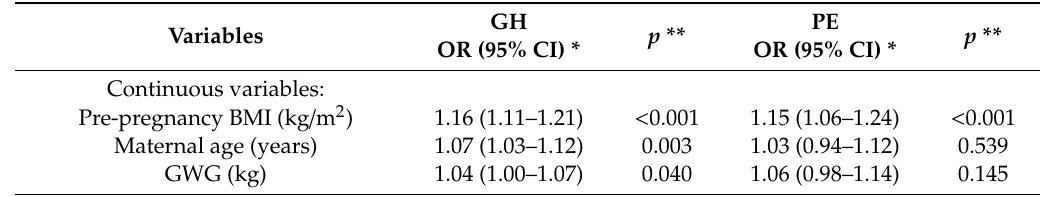
Table 2. The odds ratios of gestational hypertension (GH) and preeclampsia (PE) for selected maternal